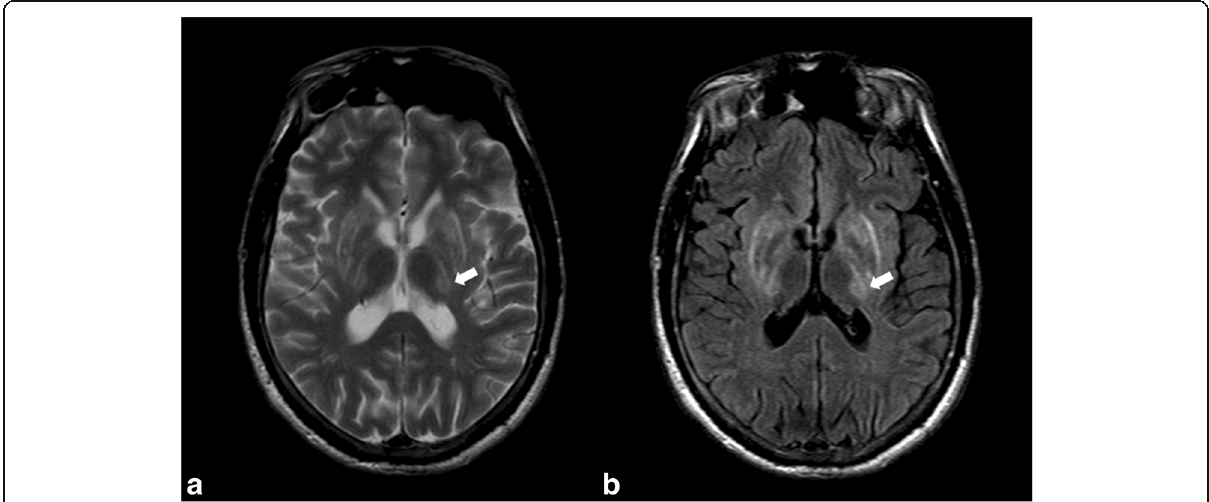
Fig. 7 High signal intensity of the basal ganglia and left thalamus (arrows) on FSE T2WI ( a ) and FLAIR ( b ) in a patient known for Wilson ’ s